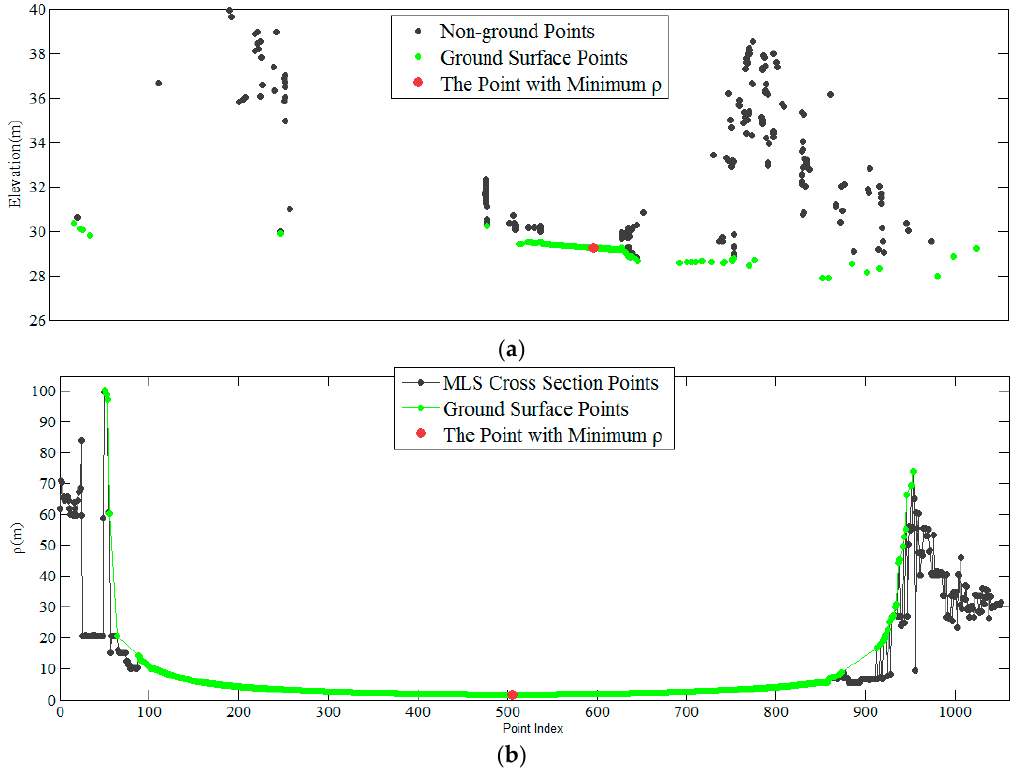
Figure 8. Characteristics of range attributes in a cross-section: ( a ) a cross-section of MLS points; ( b ) the range attributes of each point in the cross-section.